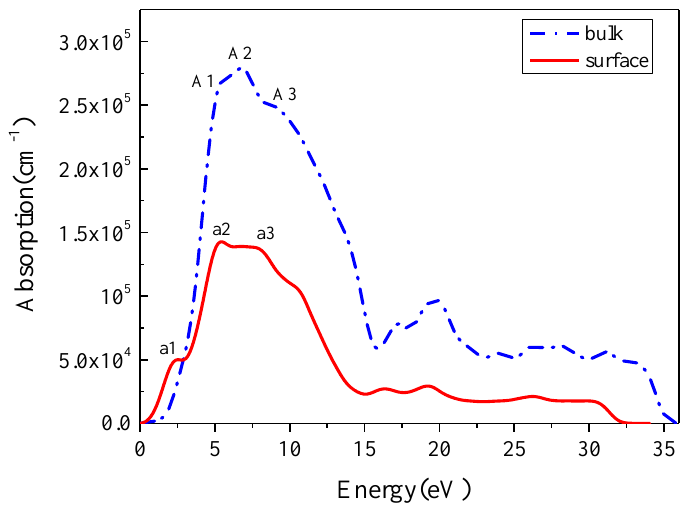
Figure 5. Absorption curves of In 0.87 Ga 0.13 As 0.25 P 0.75 bulk and In 0.87 Ga 0.13 As 0.25 P 0.75 (001)β 2 (2×4) surface.